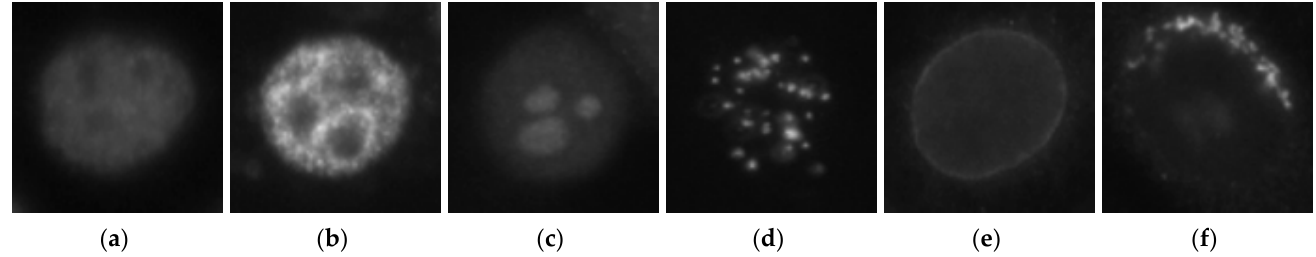
Figure 9. Example images from the large-scale HEp-2 dataset. ( a ) The homogeneous, ( b ) the speckled, ( c ) the nucleolar, ( d ) the centromere, ( e ) the nuclear membrane cells and ( f ) the Golgi cells.